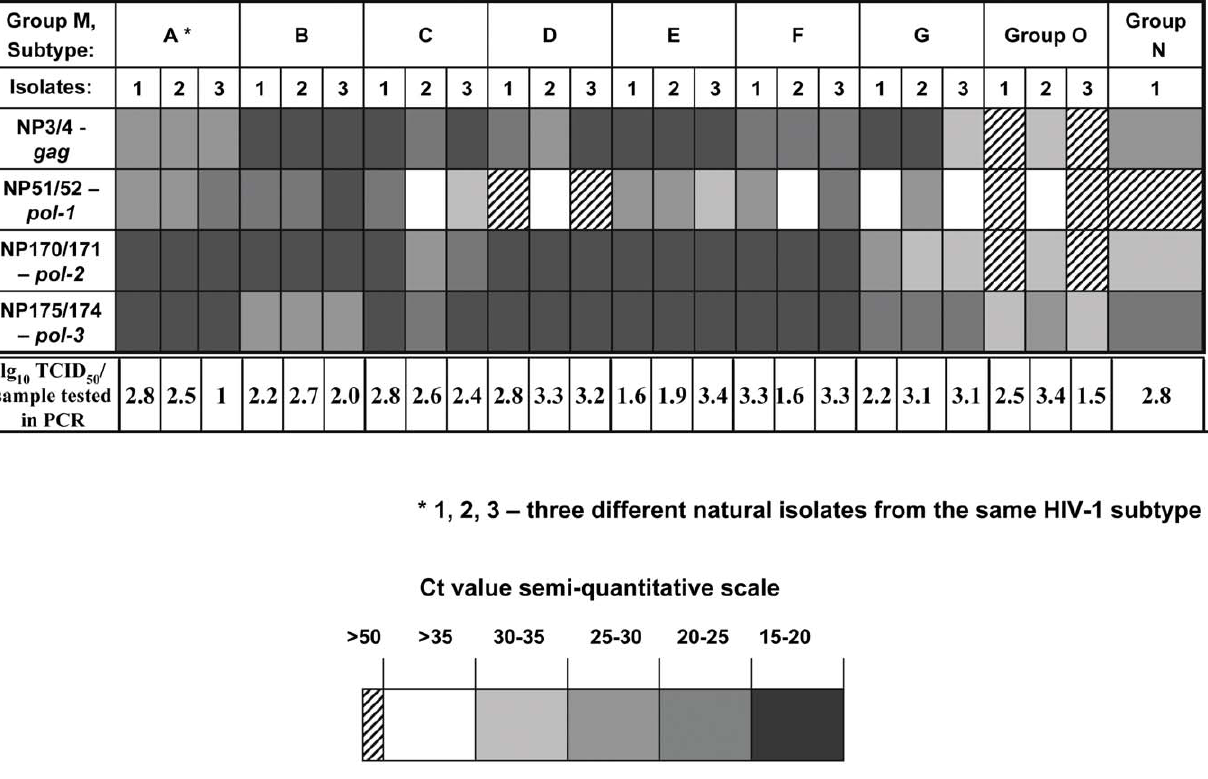
Figure 1. Semi-quantitative evaluation of four primer sets specific for HIV-1 with HIV-1 diversity panel. Total 25 HIV-1 clinical isolates from group M, O and N with three different isolates (shown as 1, 2, 3; only one group N isolate) from each HIV-1 group/subtype were used in testing. Infectious unit (IU) of the virus stocks in TCID 50 s were titrated for each isolate; the number of IU used for viral RNA isolation and PCR was calculated based on the dilution factor and ranged from , 10 to 2,500 or 1 to 3.4 log 10 TCID 50 per PCR